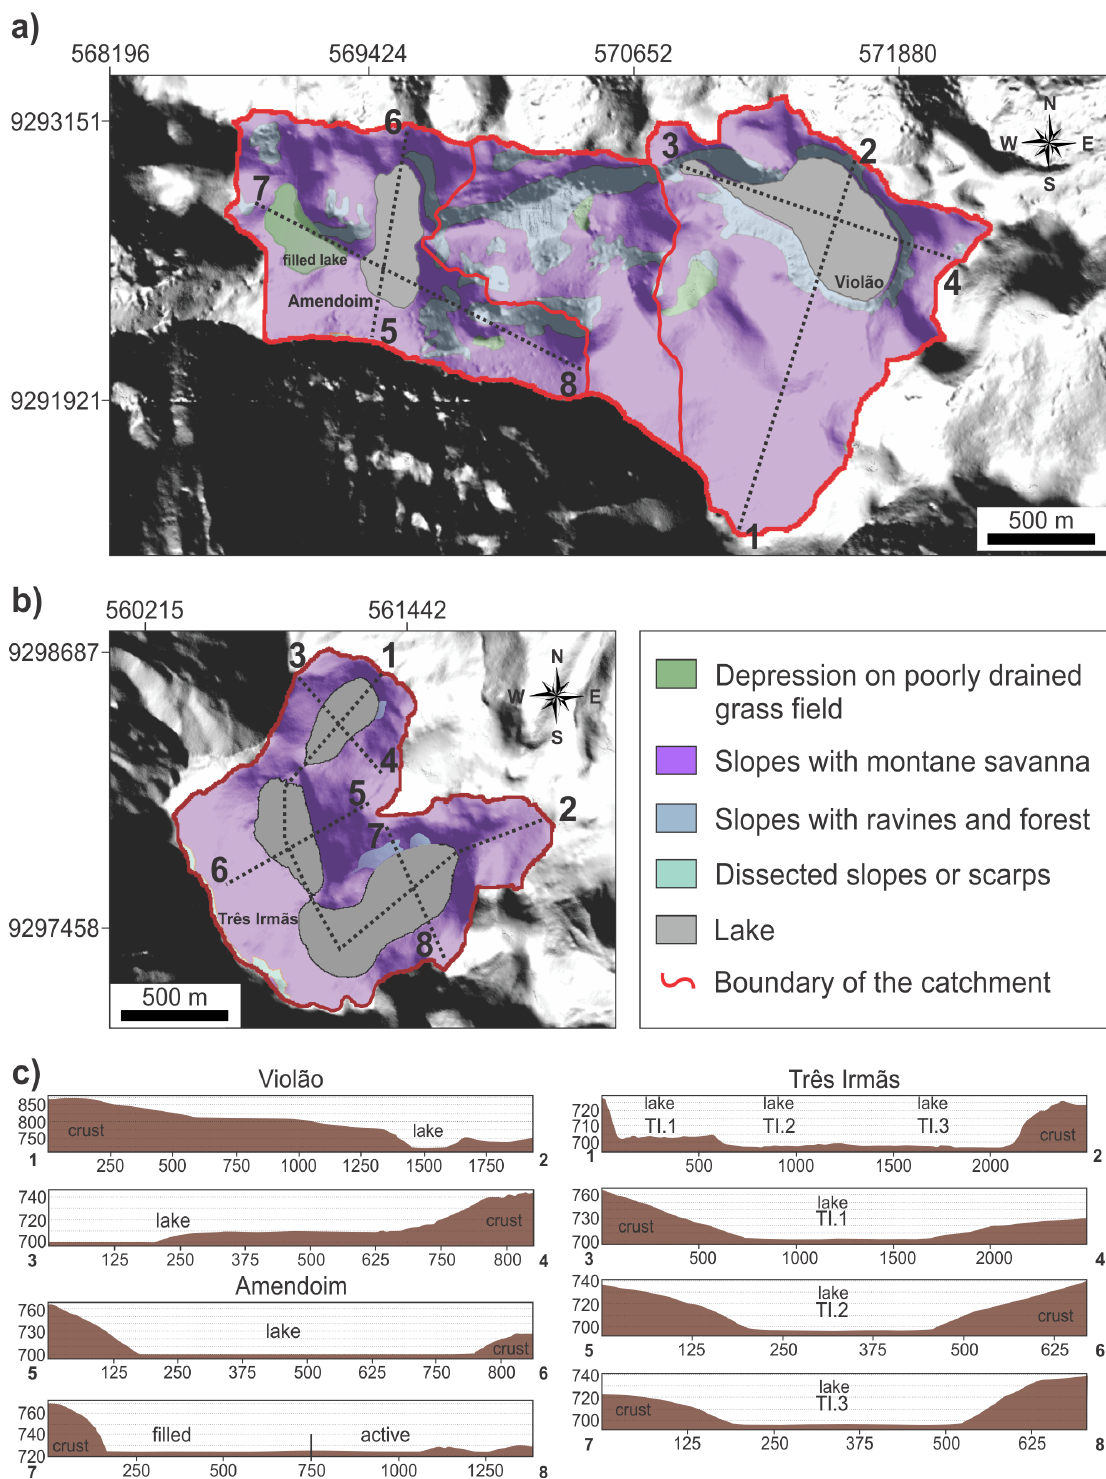
Figure 2 - Geomorphological maps of the catchment basins of the a) Violão, Amendoim and b) Três Irmãs lakes according Rezende and Barbosa (1972), and Golder (2010), with c) topographic sections of each basin; altitude and distance units are in